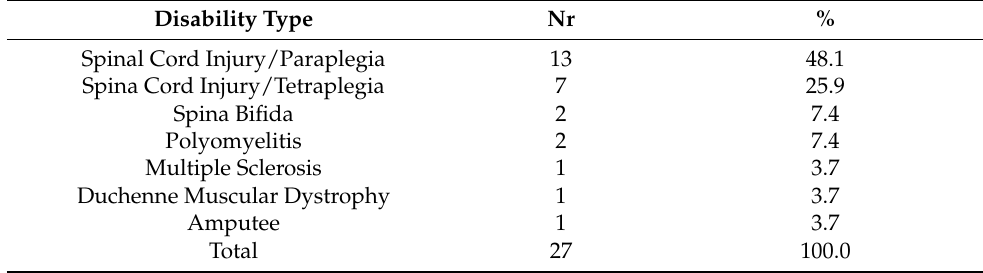
Table 1. Deaths and disability